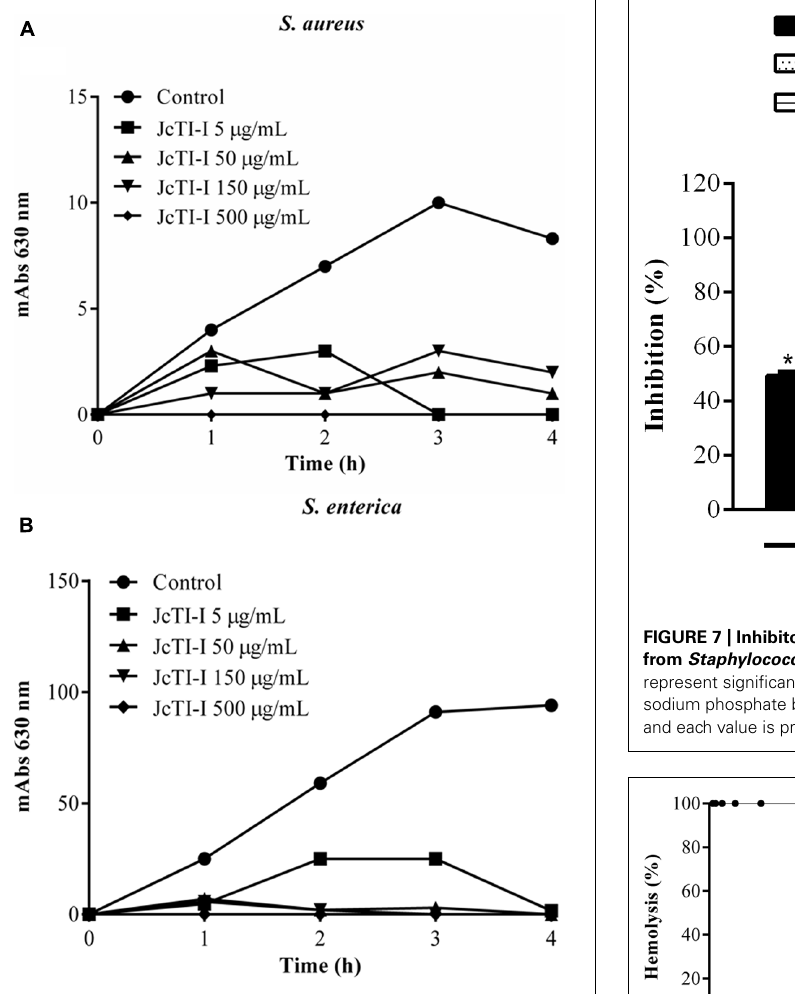
FIGURE 6 | Effect of JcTI-I at different concentrations on the growth of Staphylococcus aureus (A), and Salmonella enterica (B). Control: 0.05 M sodium phosphate buffer (pH 7.5).The minimal inhibitory concentration (MIC) of JcTI-I was determined based on these data. Assay was done in triplicate for every inhibitor concentration.The standard deviation was less than 10%.